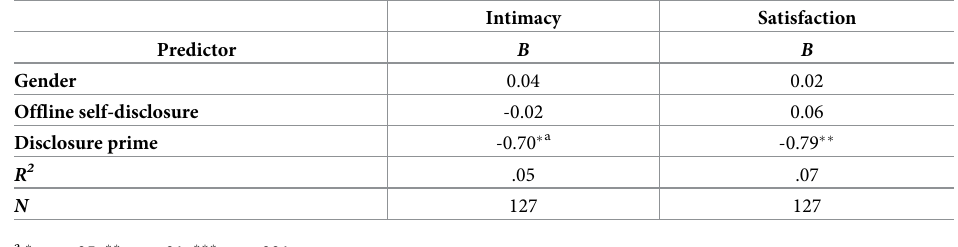
Table 3. Study 3 regression analyses predicting relationship intimacy and